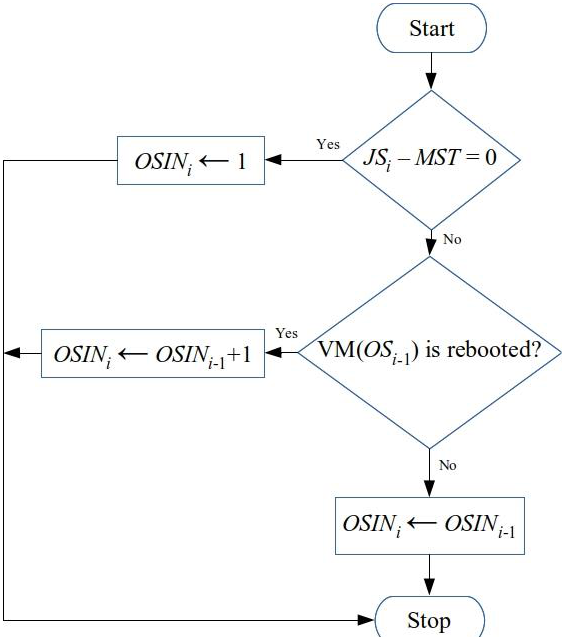
Figure 2. Supply appropriate values for the OSIN field.